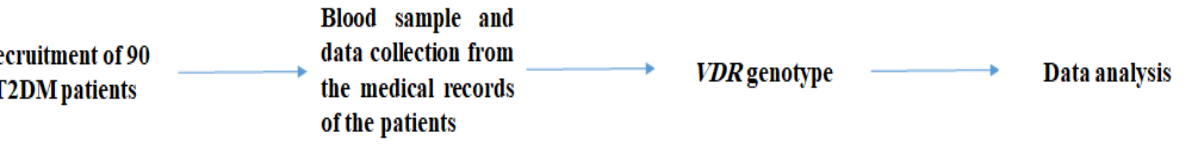
Figure 1. The flowchart of the research design.